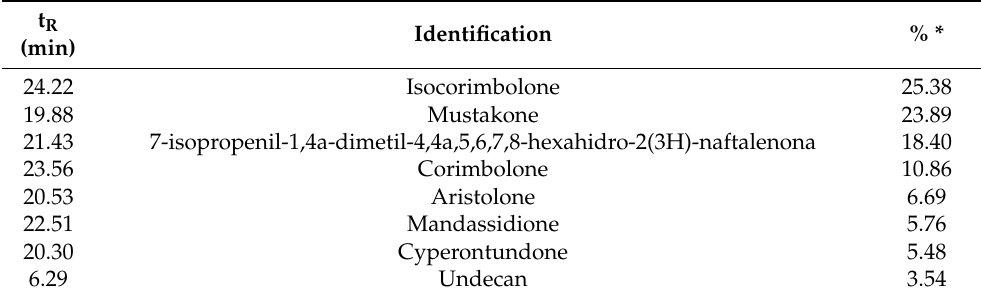
Table 1. Major constituents identified through GC-MS and their respective concentrations found in ethanolic extract of the rhizome of Cyperus articulatus (EECA).